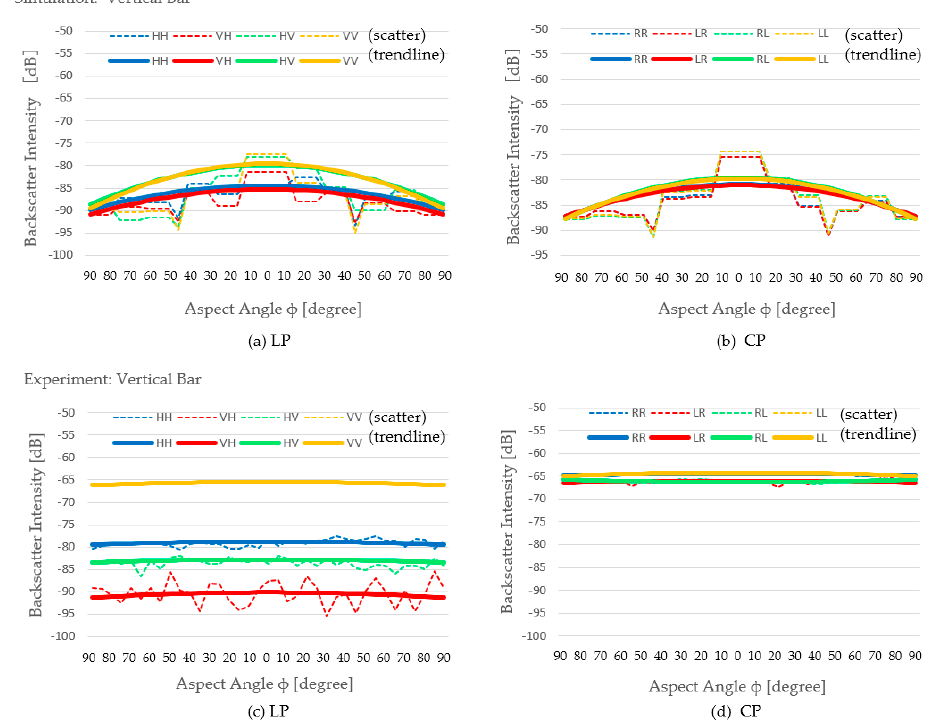
Figure 12. Backscatter intensity of a medium-sized vertical bar ((l / λ = 6.3, w / λ = 0.4): ( a ) Simulation result of LP, ( b ) simulation result of CP, ( c ) experimental result of LP, and ( d ) experimental result of CP.